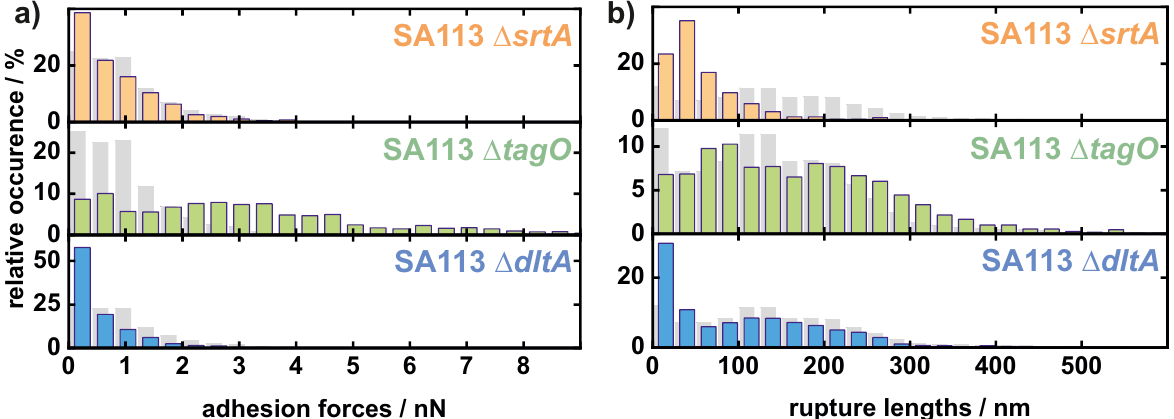
Figure 4. Histograms of all measured values of adhesion force ( a ) and rupture length ( b ) of 11 single SA113 ∆ srtA , 15 single SA113 ∆ tagO , and 18 single SA113 ∆ dltA cells on hydrophilic surfaces. The corresponding values of an SA113WT population are shown in gray